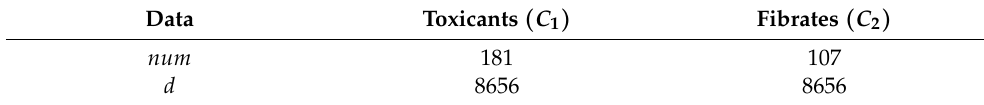
Table 1. GSE2187 data structures: number of data ( num ), data dimension ( d ).